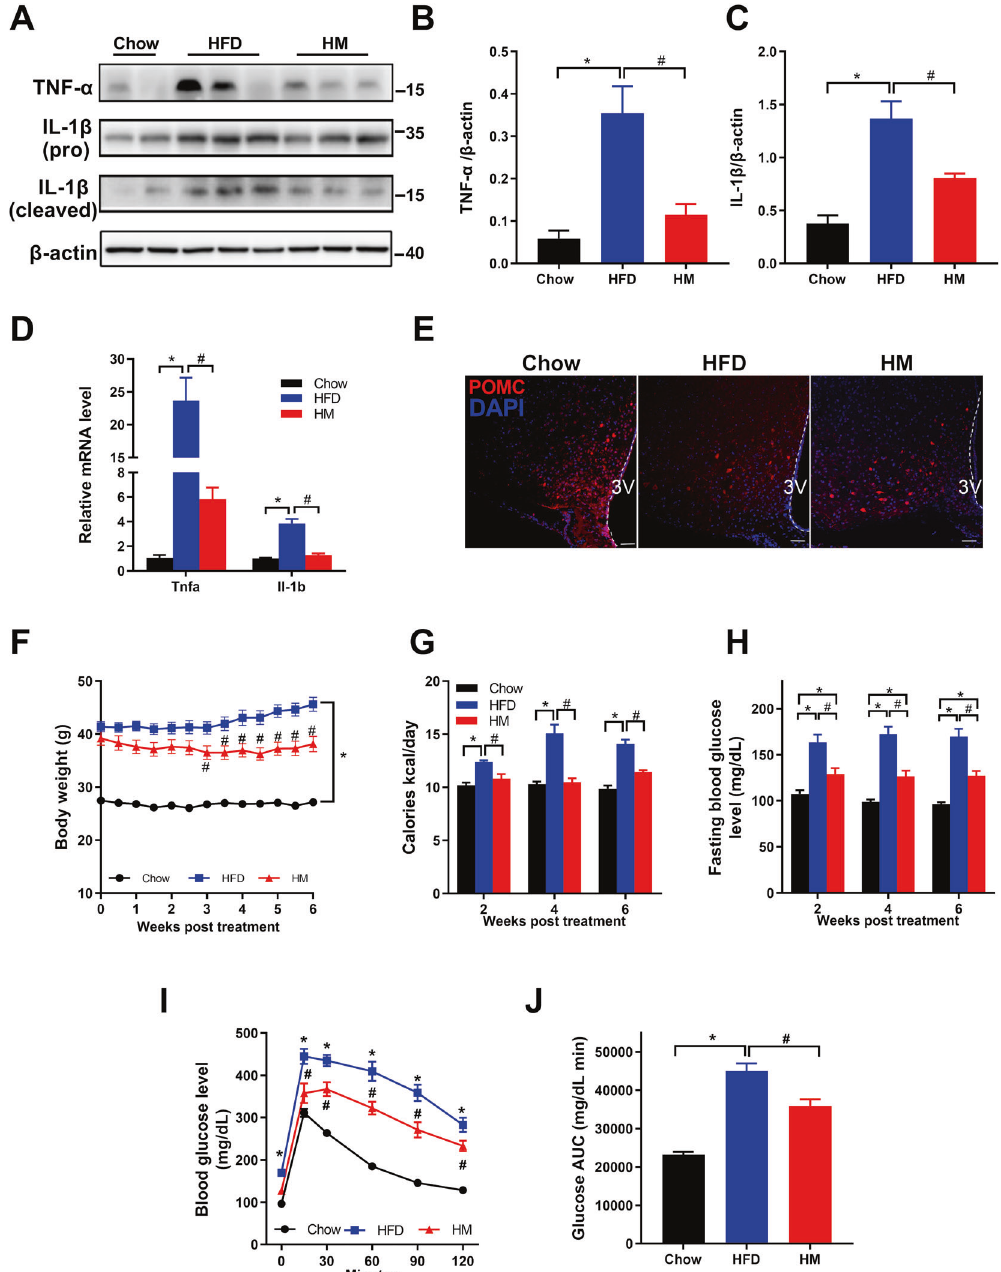
Fig. 2 Metformin treatment attenuated hypothalamic in fl ammation, leading to body weight loss and glucose homeostasis improvement in DIO mice. A – C Immunoblotting data showed elevated expression of TNF- α and IL-1 β in the hypothalamus from HFD mice. The overexpression of these proin fl ammatory cytokines in the hypothalamus was declined in HM mice. D qPCR results that aligned with the data in immunoblotting. E Immunostaining for POMC cells (red) in the MBH ( n = 4) showed metformin protection of POMC cells from HFD-induced injury. Scale bar represented 50 μ m. F – J General index demonstrated the bene fi cial effects of metformin on obese mice. F and G Metformin lowered the body weight signi fi cantly and the caloric intake in HM mice compared with those in HFD mice. H Metformin downregulated fasting blood glucose concentration in DIO mice. I Glucose tolerance test (GTT, glucose 1 g/kg intraperitoneally) in mice fasted for 12 – 16 h. J Areas under the curve (AUC) for GTT ( n = 7). The data were presented as mean ± SEM. * P < 0.05 vs. Chow mice; # P < 0.05 vs. HFD mice.